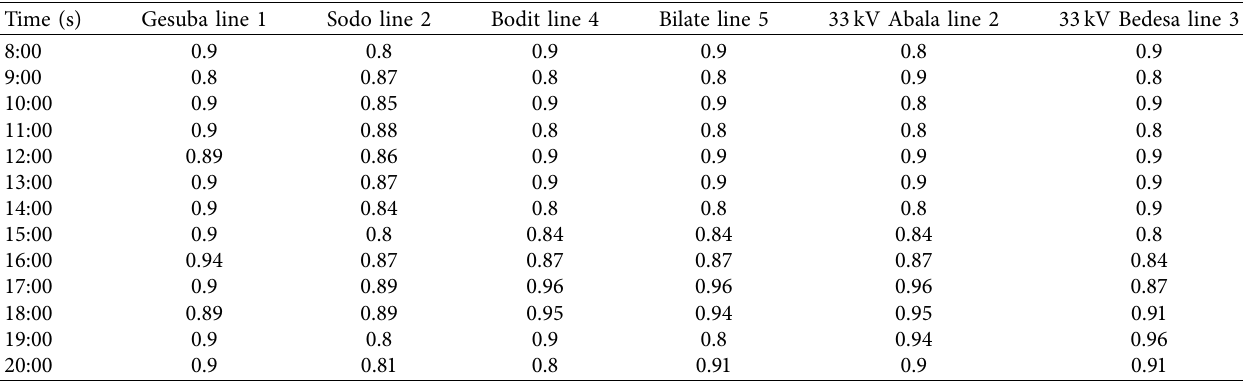
Table 2: Power factor for the distribution lines of